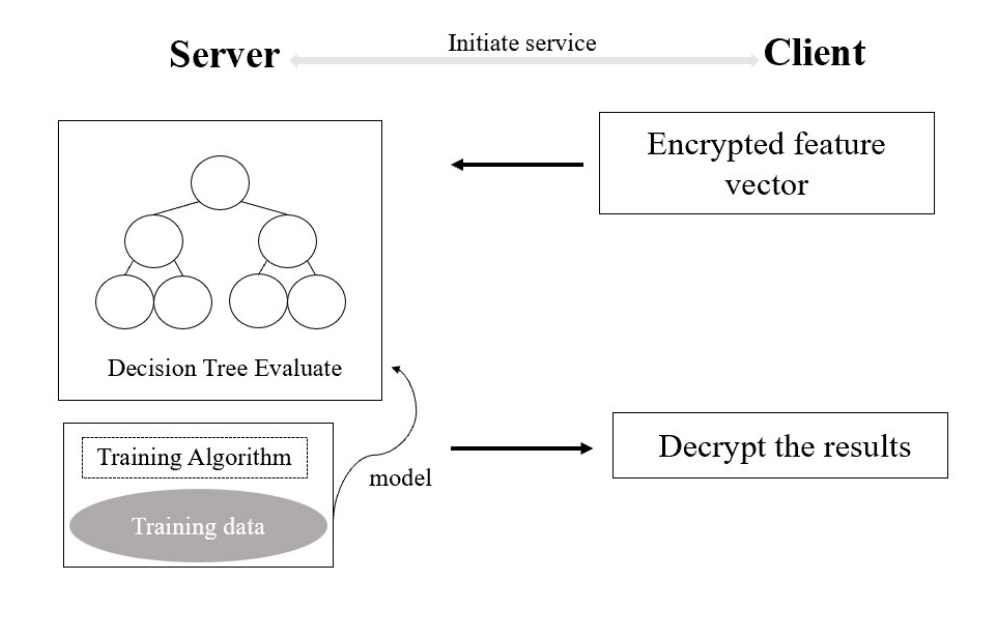
Figure 2. Architecture of private decision-tree classification.